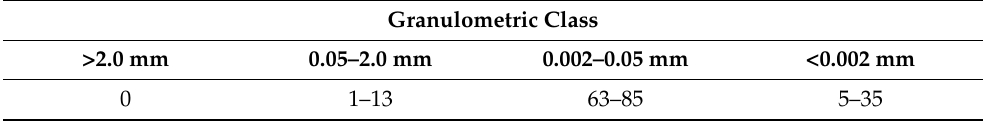
Table 2. Granulometric composition of the post-flotation sediment (%